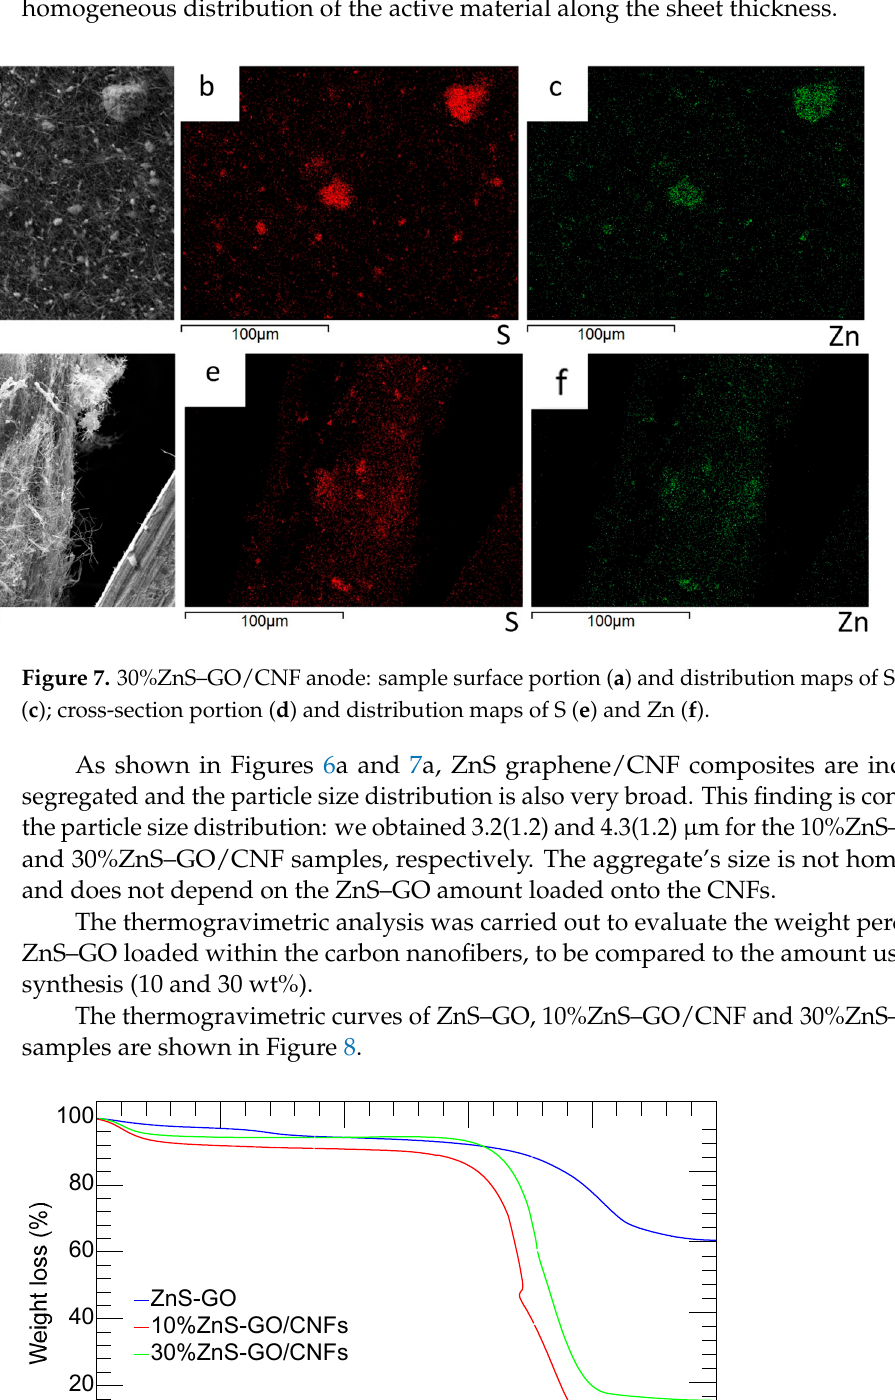
Figure 6. 10%ZnS–GO/CNF anode: sample surface portion ( a ) and distribution maps of S ( b ) and Zn ( c ); cross-section portion ( d ) and distribution maps of S ( e ) and Zn ( f ).